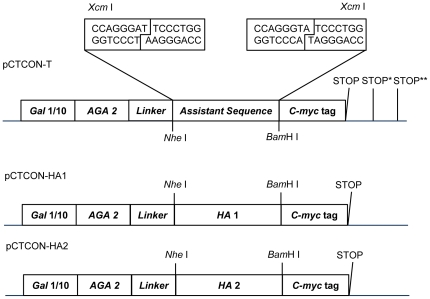
Vectors constructed in the study.Vector pCTCON-T was derived from pCTCON-2 [23] by inserting an assistant sequence with two Xcm I sites at both ends between Nhe I and BamH I sites. Digestion of pCTCON-T yielded a T vector for TA ligation with random fragments of the H1N1 HA gene. ‘Stop’, ‘Stop*’ and ‘Stop**’ stand for three different stop codons for three possible ORFs, respectively. The random peptide library was expressed under the control of the galactose inducible GAL 1/10 promoter and displayed on the surface of the yeast cells by fusion to the yeast adhesion receptor AGA 2 protein. Vectors pCTCON-HA1 and pCTCON-HA2, created by inserting HA1 and HA2 genes between the Nhe I, BamH I sites of pCTCON-2, were used as positive controls in FCM detection.